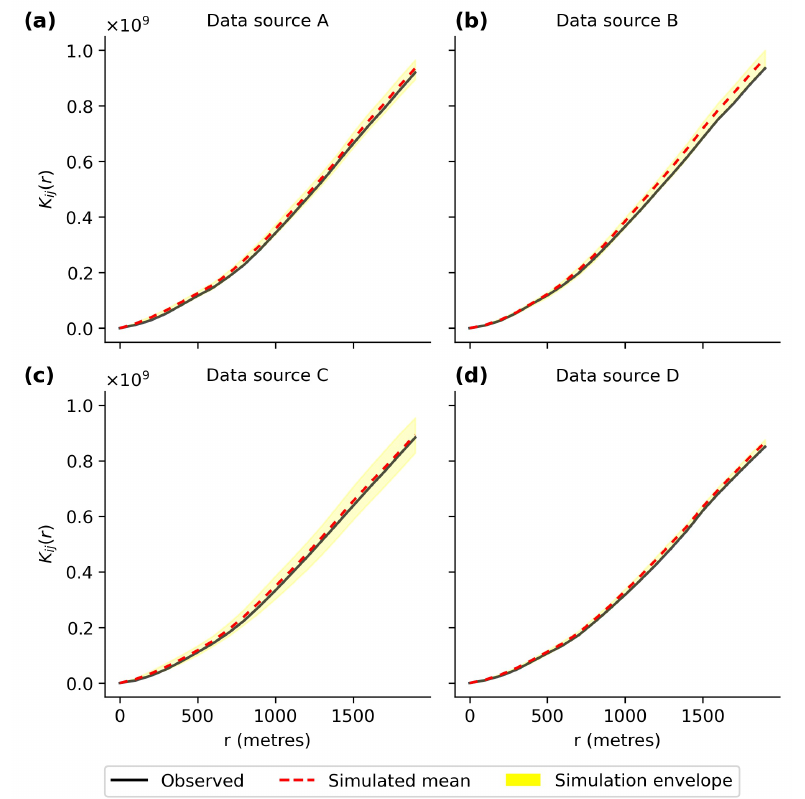
Figure 5. Cross-K functions of D eval against D ref for the four data sources A to D ( a – d